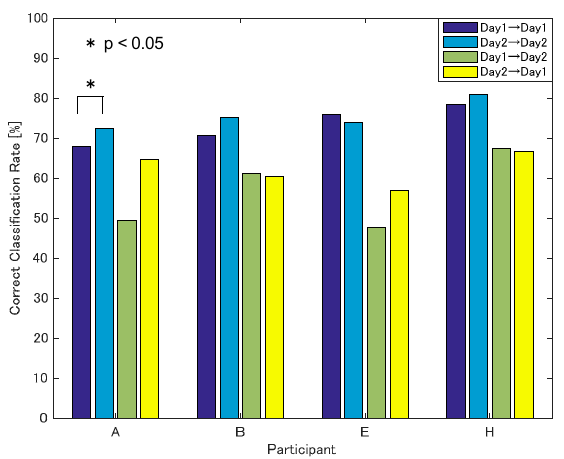
Figure 14. Comparison of mean correct rates of each classification scenario (9 movements). (*) represents p < 0.05.